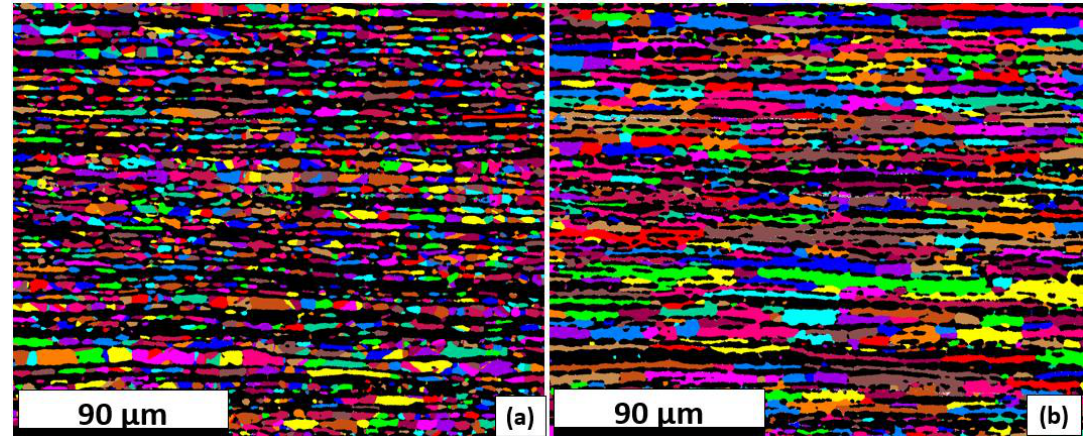
Figure 5. ( a ) Ferrite and ( b ) austenite grain maps of the industrial microstructure with a minimum misorientation of 15°.